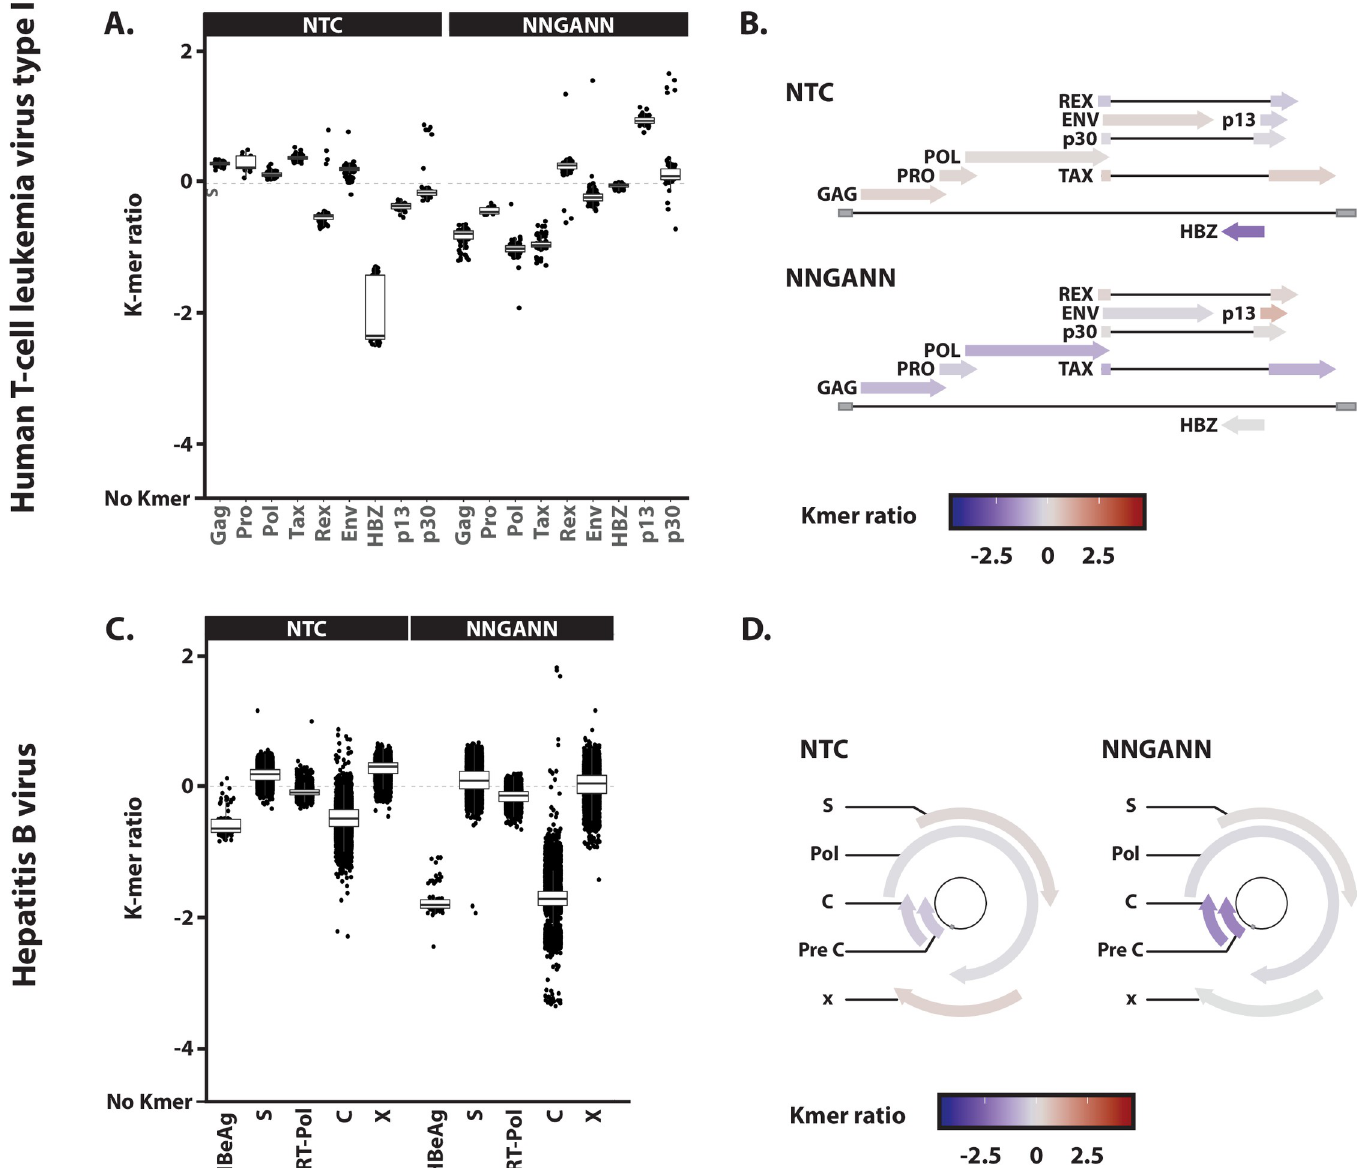
Fig 10. A3 footprint on the negative strand of HTLV-1 and HBV. A. NTC and NNGANN observed/expected ratios were calculated for the different genes of HTLV-1. B. Each gene specific NTC and NNGANN ratio median values were reported on HTLV-1 genome map by a colored scale. C. NTC and NNGANN observed/expected ratios were calculated for the different genes of HBV. D. Each gene specific NTC and NNGANN ratio median values were reported on HBV genome map by a colored scale.